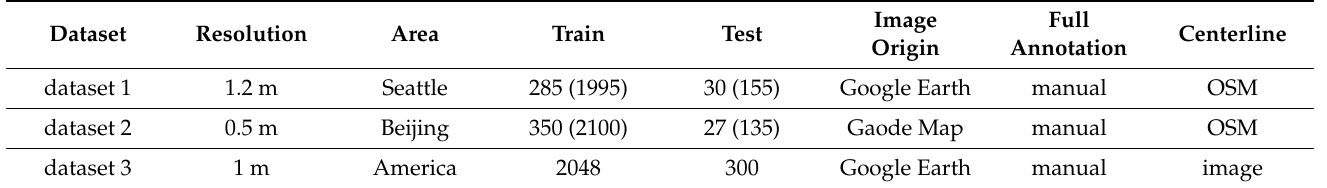
Table 1. Dataset Description (For dataset 1 and dataset 2, the numbers in parentheses are the amount of data after